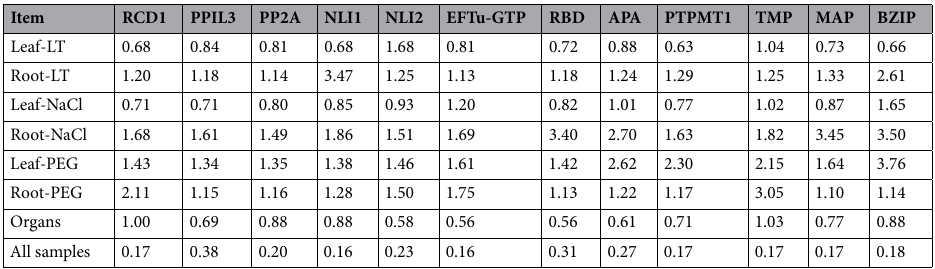
Table 3. Stability of candidate reference genes according to the ΔCt